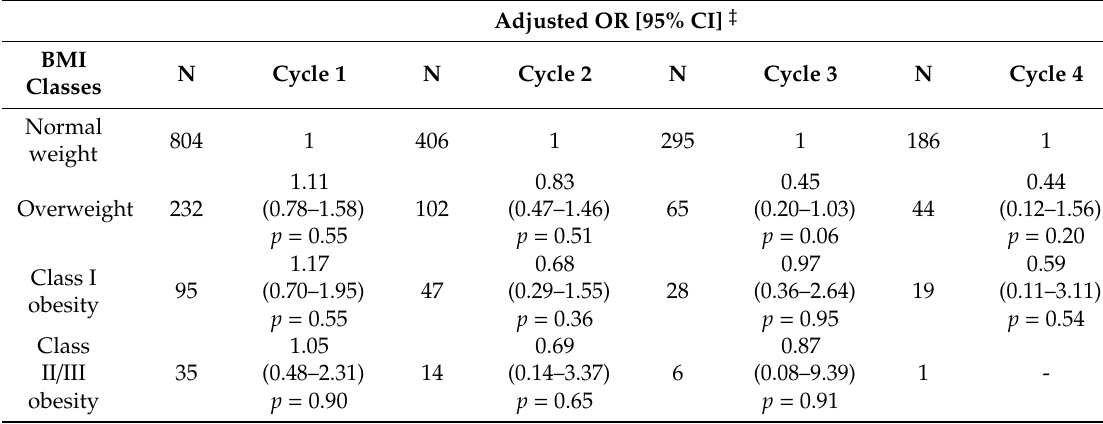
Table 3. Adjusted Odds Ratios for Obtaining a First Live Birth by BMI Class.